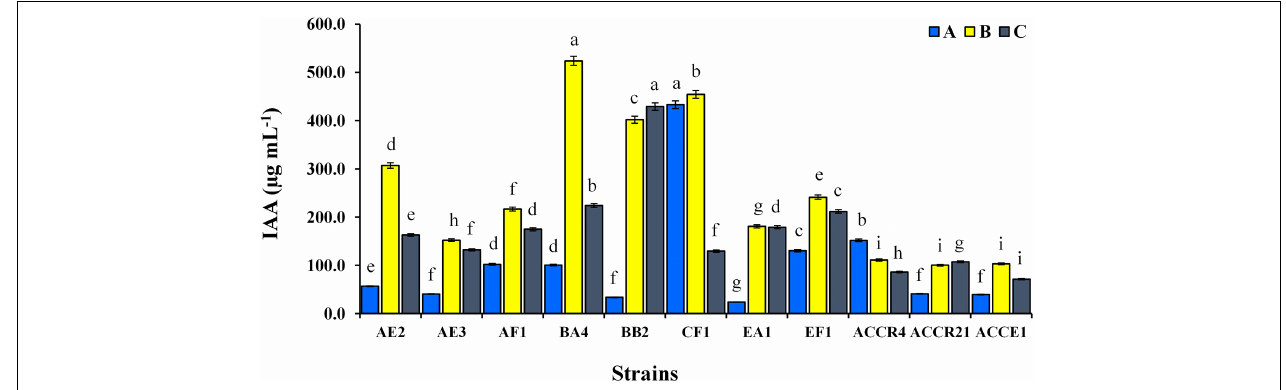
FIGURE 2 | Indole-3-acetic acid production of endophytic bacterial isolates at different concentrations of L -tryptophan (A) absence of L -tryptophan and (B,C) presence of L -tryptophan (0.5 and 1.0 g L − 1 ). Dissimilar lowercase letters show a significant difference at p ≤